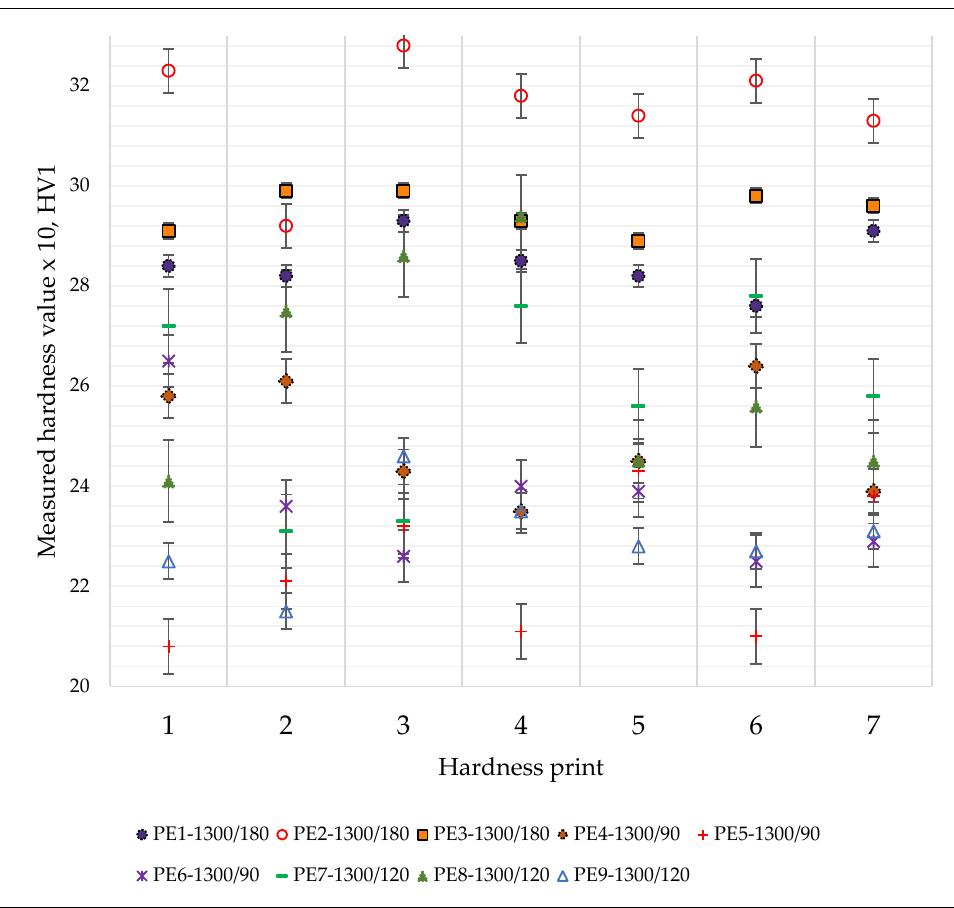
Figure 5. Microhardness values measured on the specimens sintered at 1300 °C.